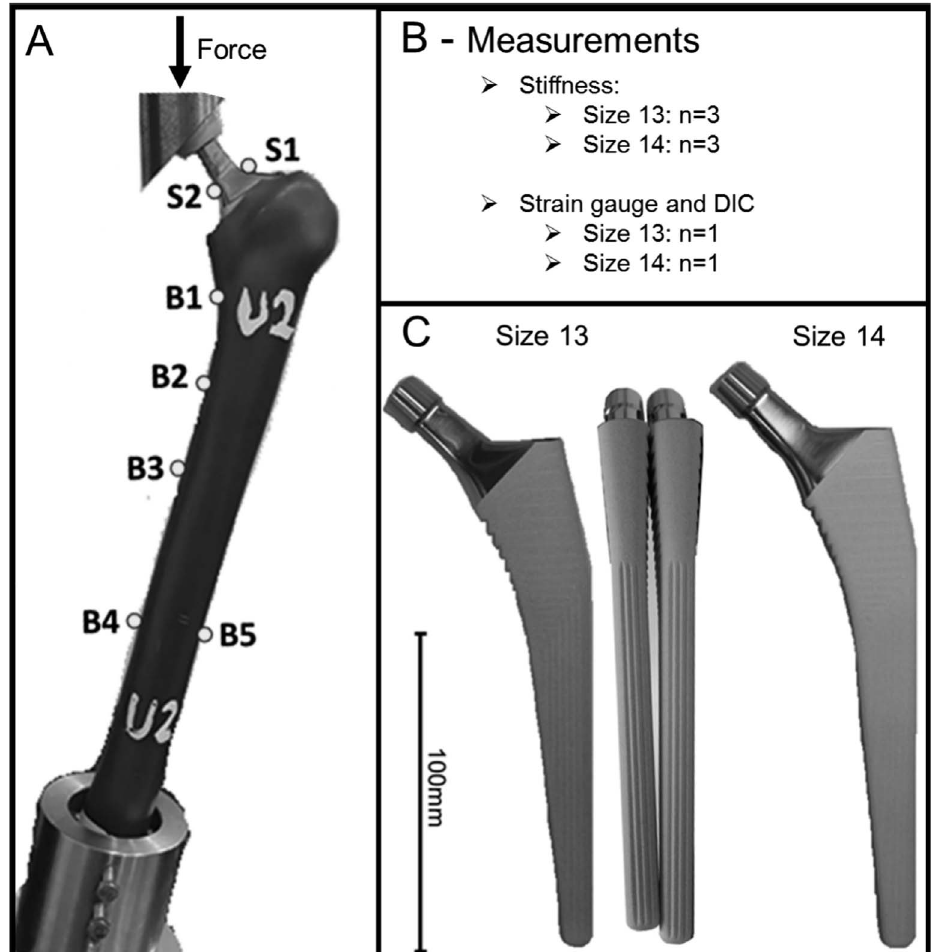
Figure 1. Overview of the study. Experimental setup of total hip replacement (A), measurements obtained (B), and the two different stem sizes used (C). S1 – S2 highlight the strain gauge attachment site on the stem, and B1 – B5 highlight the strain gauge attachment site on the bone. Size 13 N =